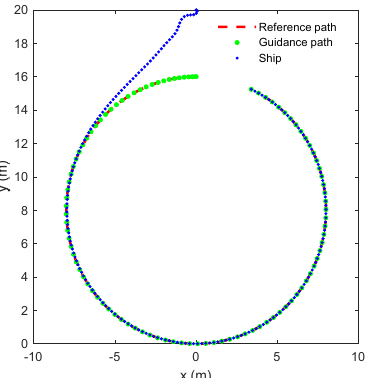
Figure 5. The performance of curved path following.